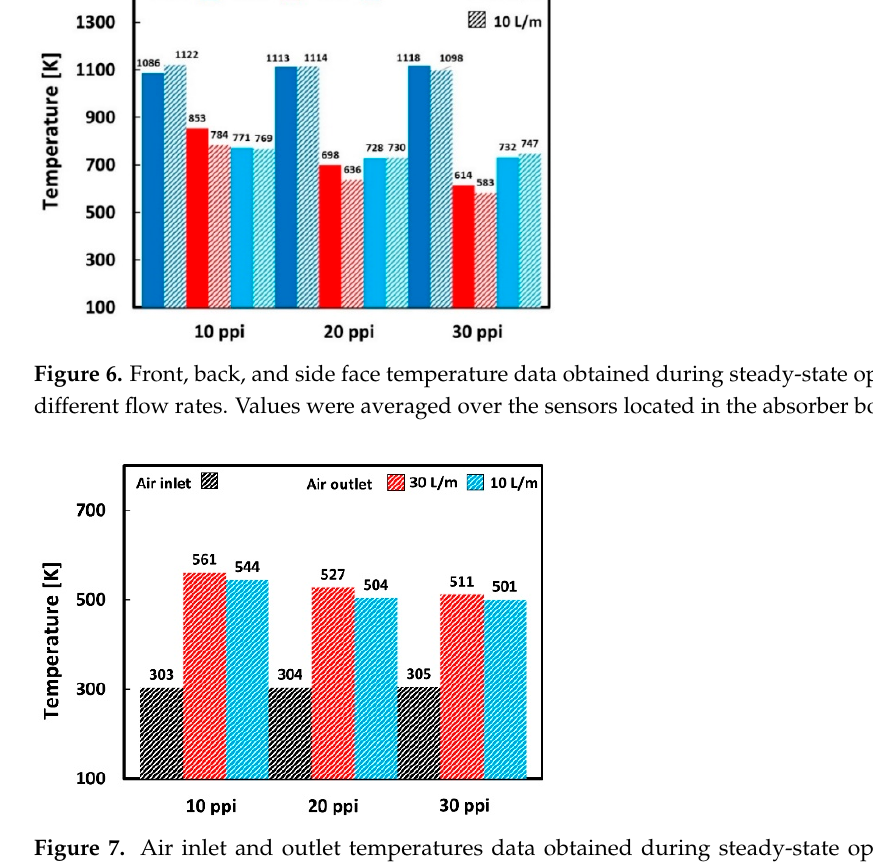
Figure 8. Isothermal surfaces corresponding to the 20 PPI absorber obtained from numerical sim- ulations.